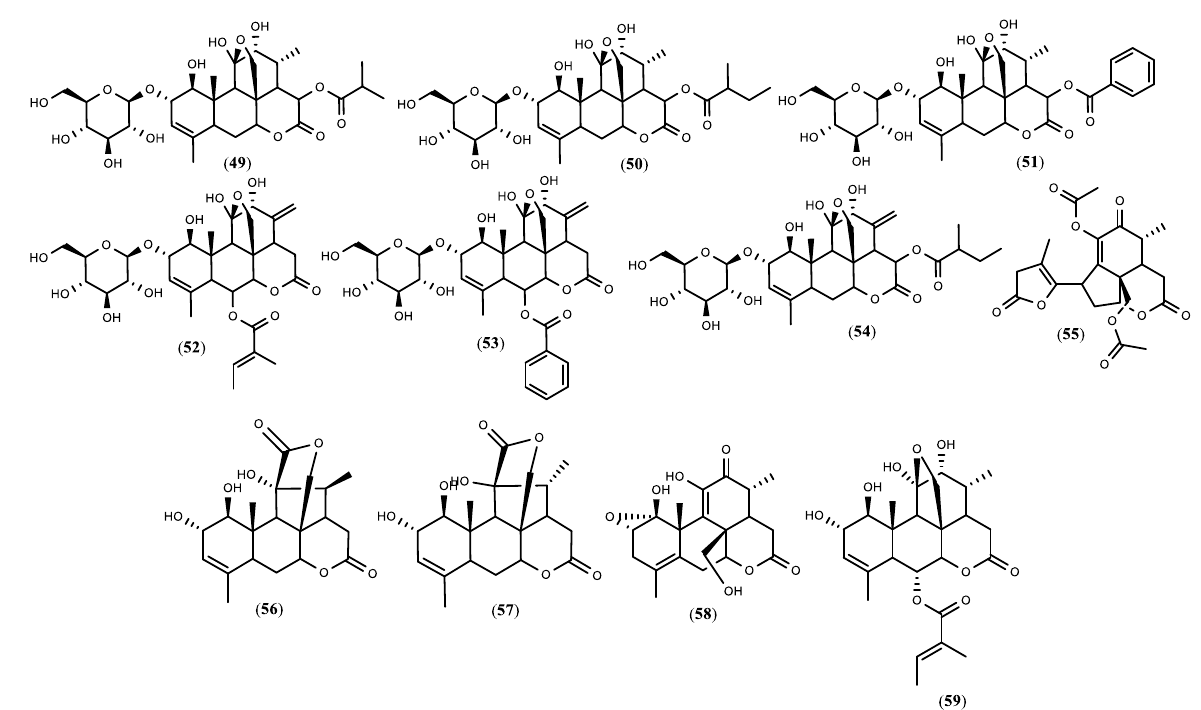
Figure 1. The structure of quassinoids isolated from A. altissima . The compound numbers correspond to the list in Table 1.